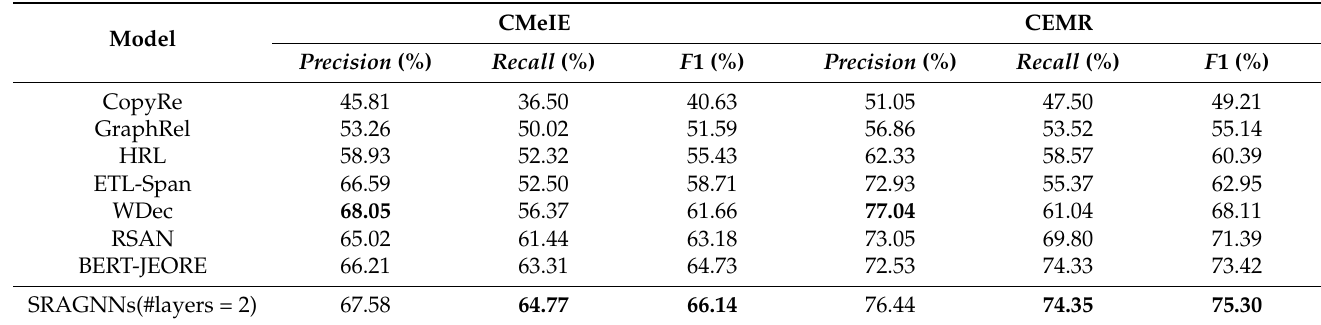
Table 4. Results on CEMR and CMeIE.